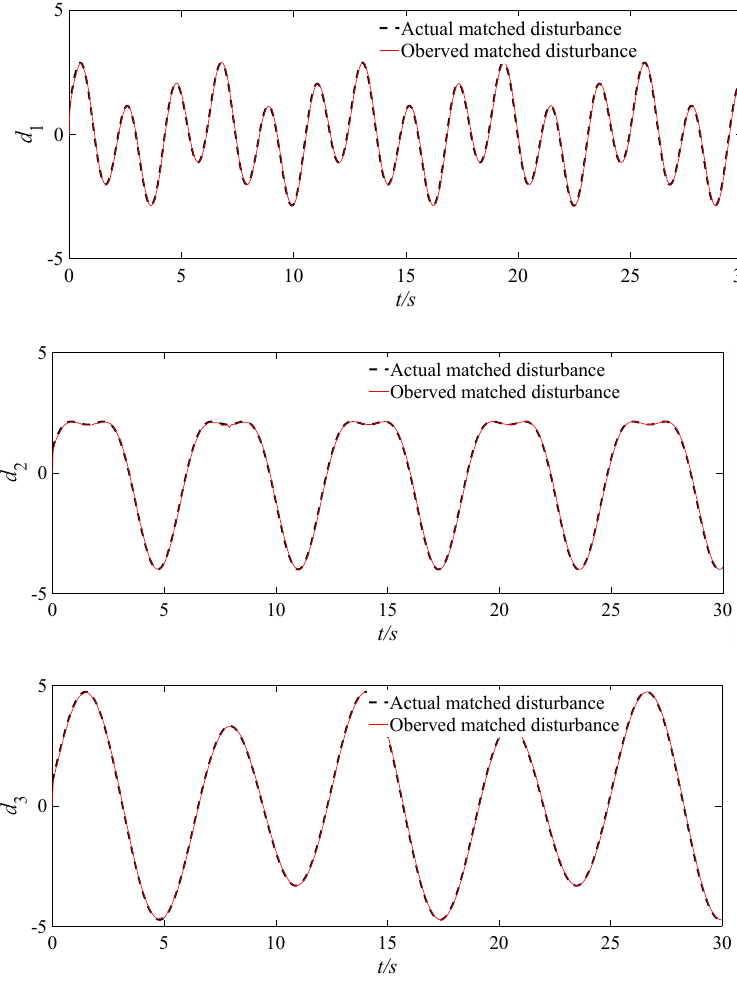
Furthermore, this study also conducts an experiment on the quadrotor aircraft flight simulation software (QDroneGimbalSim) produced by the Quanser Company. The exper- iment is carried out in a cubic space with a side of 2 m, the vector of the initial position and yaw angle is [ X Y Z yaw ] = [ 0 0 1.5 0 ] , and the vector of the desired position and yaw angle is [ X Y Z yaw ] = [ − 2 − 2 1.5 0.2 ] ; the simulation results are shown in Figure 6.